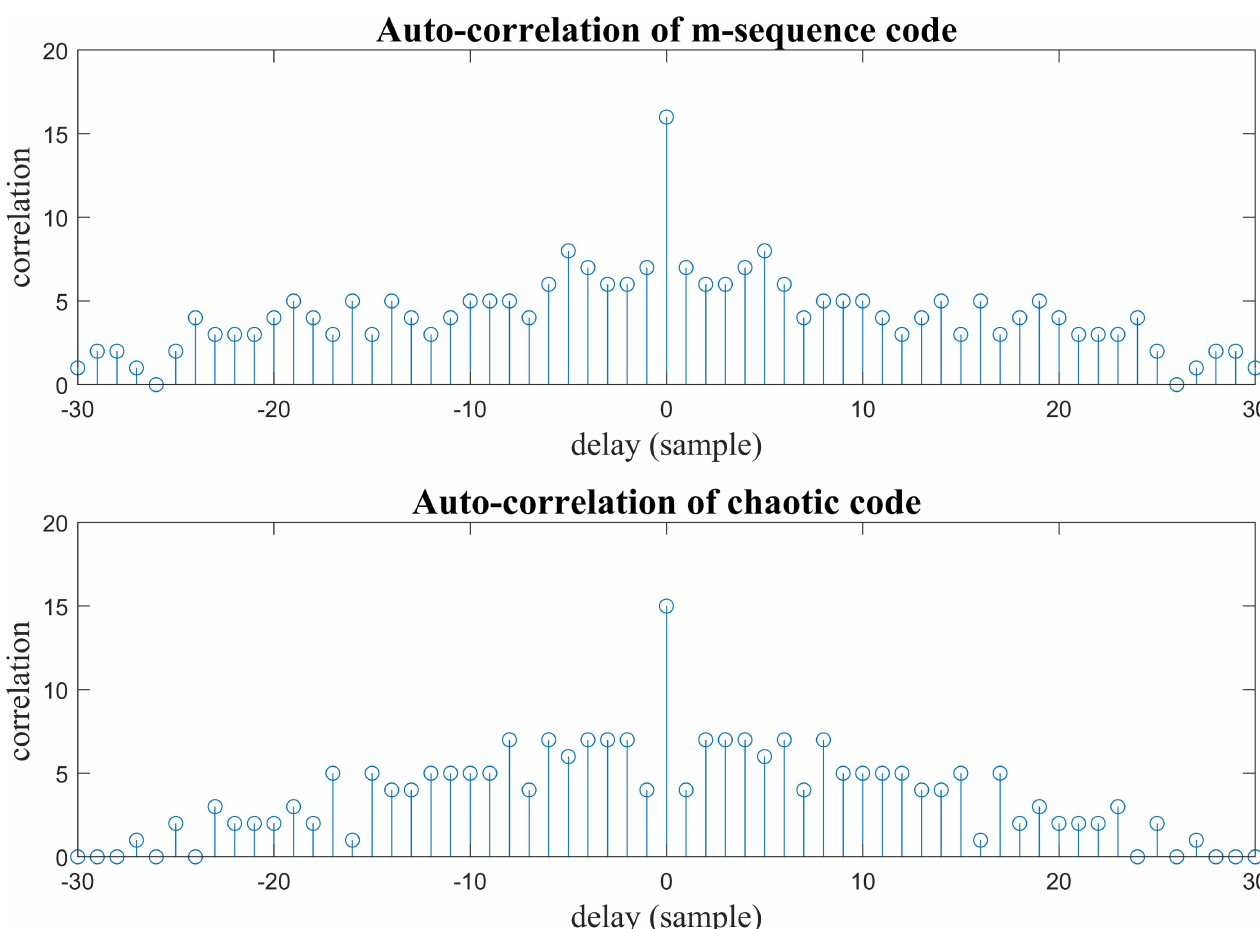
Fig 3. The auto-correlation of m-sequence code (top) and chaotic code (bottom). The generated chaotic code follows the correlation property which is necessary in code modulation.